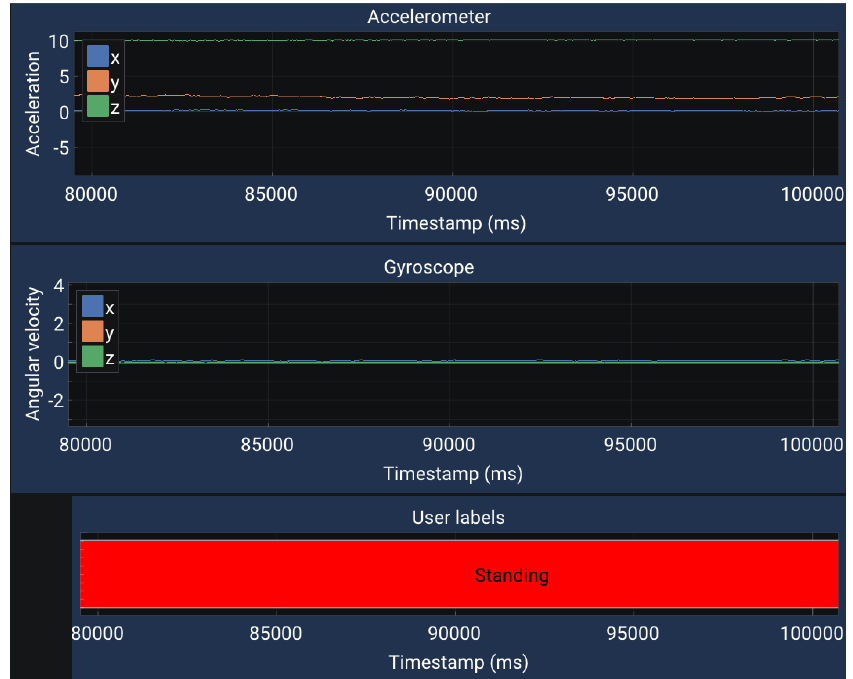
Figure A3. 20 s extracted from STANDING session of subject